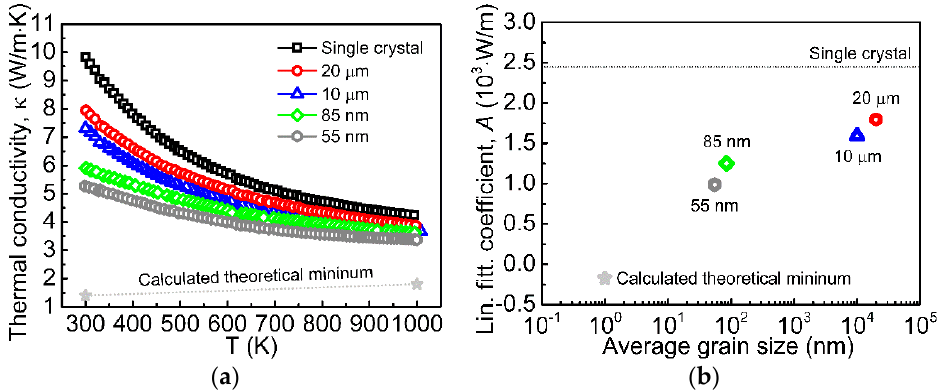
Figure 3. Temperature dependence ( a ) of effective thermal conductivity for SrTiO 3 polycrystalline ceramics and single crystal (also shows a calculated theoretical minimum for disordered crystals with few nm grain size). Size dependence ( b ) of linear coefficient A for fitting κ ( T ) = κ o + A / T + B / T 2 . Estimated average grain sizes are shown for some representative samples according to Reference [10].